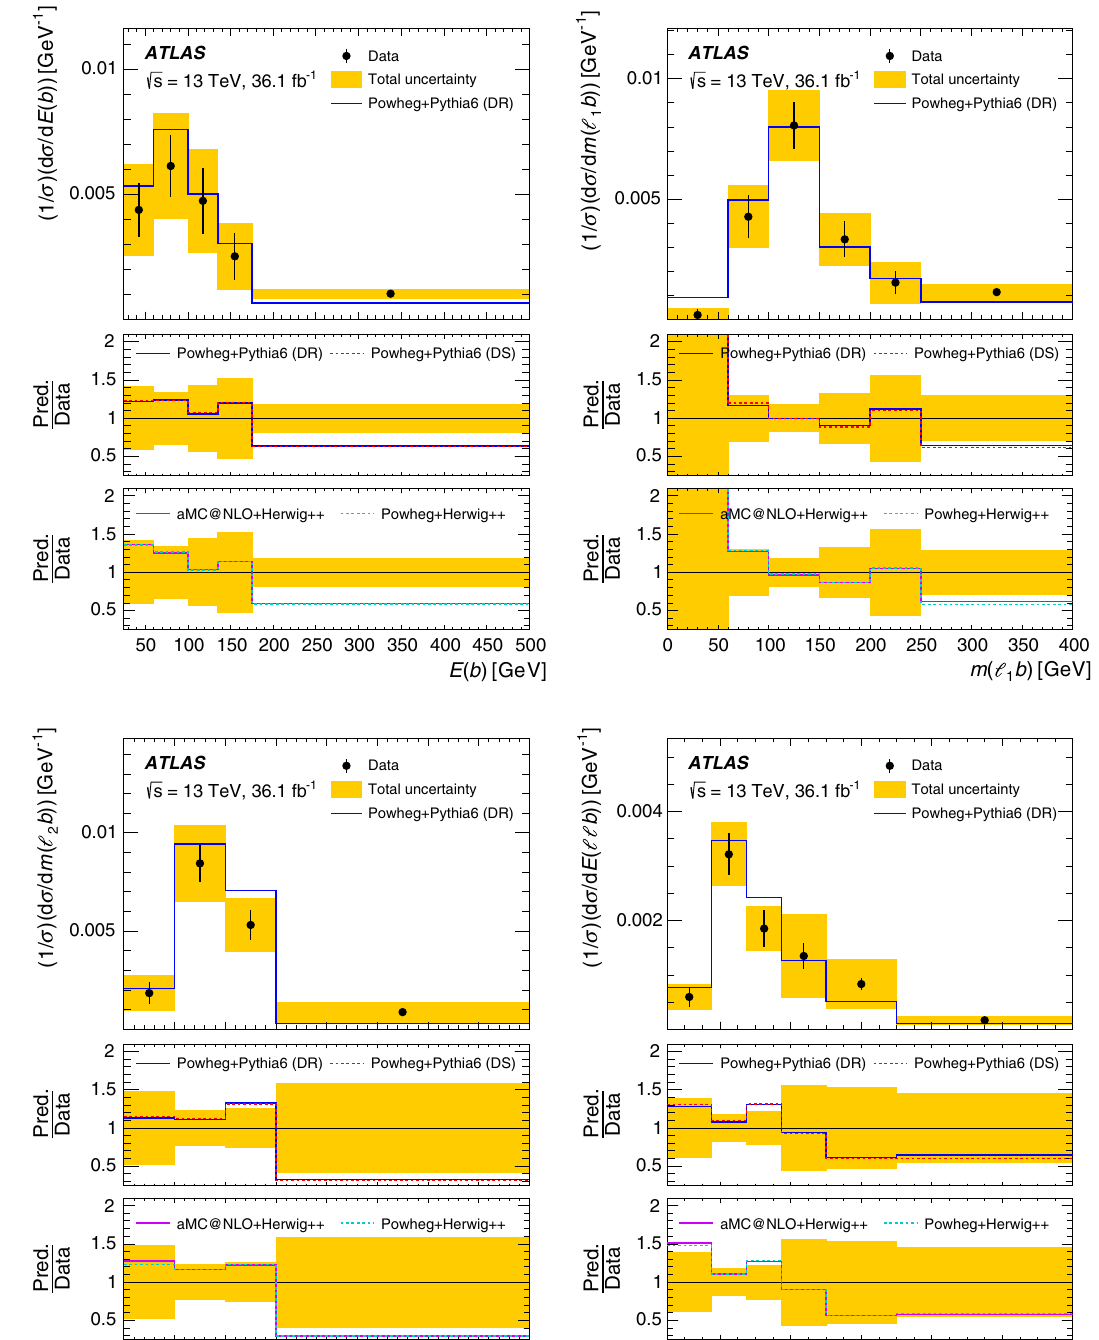
Fig. 5 Normalised differential cross-sections unfolded from data, compared with selected MC models, with respect to E ( b ) , m ((cid:6) 1 b ) , m ((cid:6) 2 b ) , and E ((cid:6)(cid:6) b ) . Data points are placed at the horizontal centre of each bin, and the error bars on the data points show the statistical uncer-